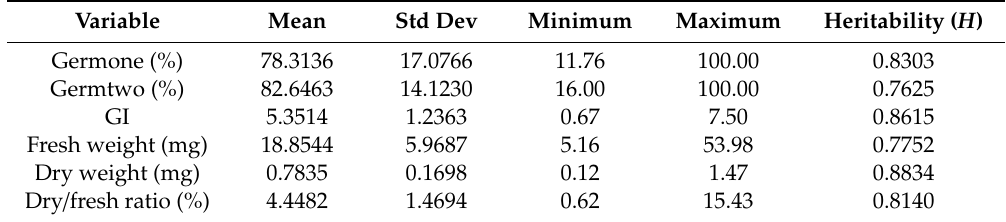
Figure 2. ( a ) Best linear unbiased predictor (BLUP) values of germination rate after 5- and 9-days of planting and germination index (GI) for 211 C. sativa accessions germinated under 100 mM NaCl; and ( b ) dry weight BLUPs of the 211 C. sativa accessions germinated under 100 mM NaCl. Table 2. Statistics summary of germination traits in Camelina sativa under salt stress condition (100 mM NaCl).